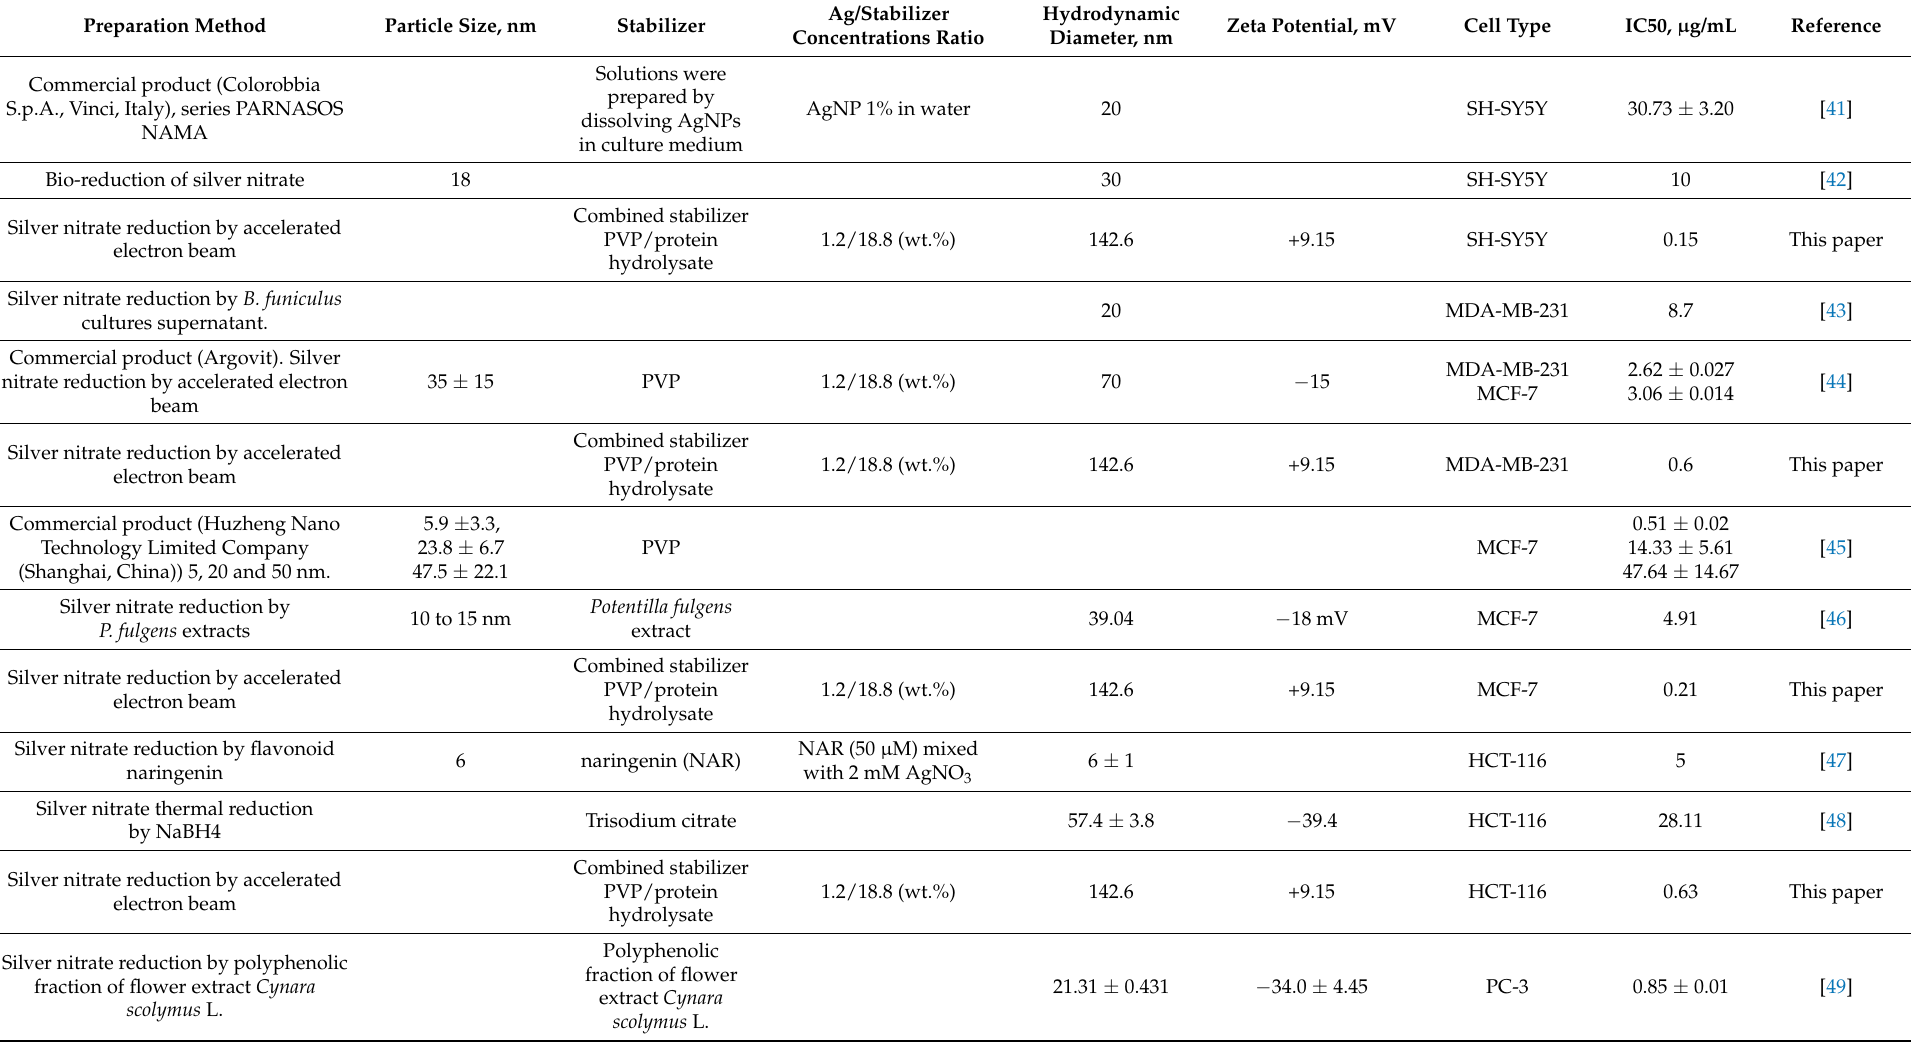
Table 1. IC50 of cancer cell lines for different AgNPs